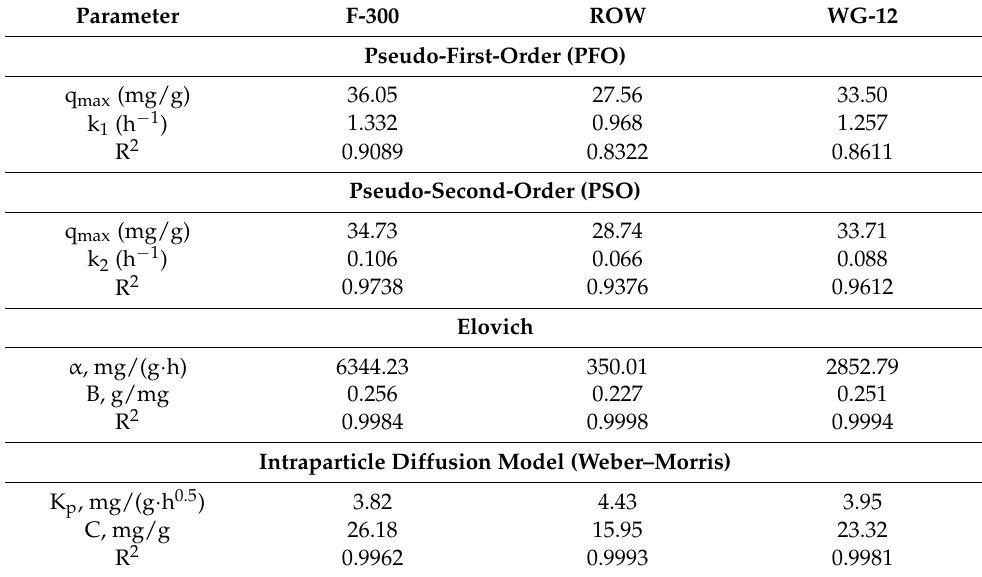
Table 6. Kinetic equation constants: PFO, PSO, intraparticle diffusion model (Weber–Morris) and Elovich. Parameter F-300